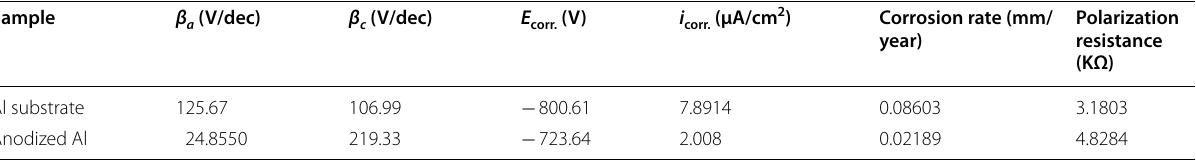
Table 2 Tafel parameters of aluminum and anodized aluminum samples Sample